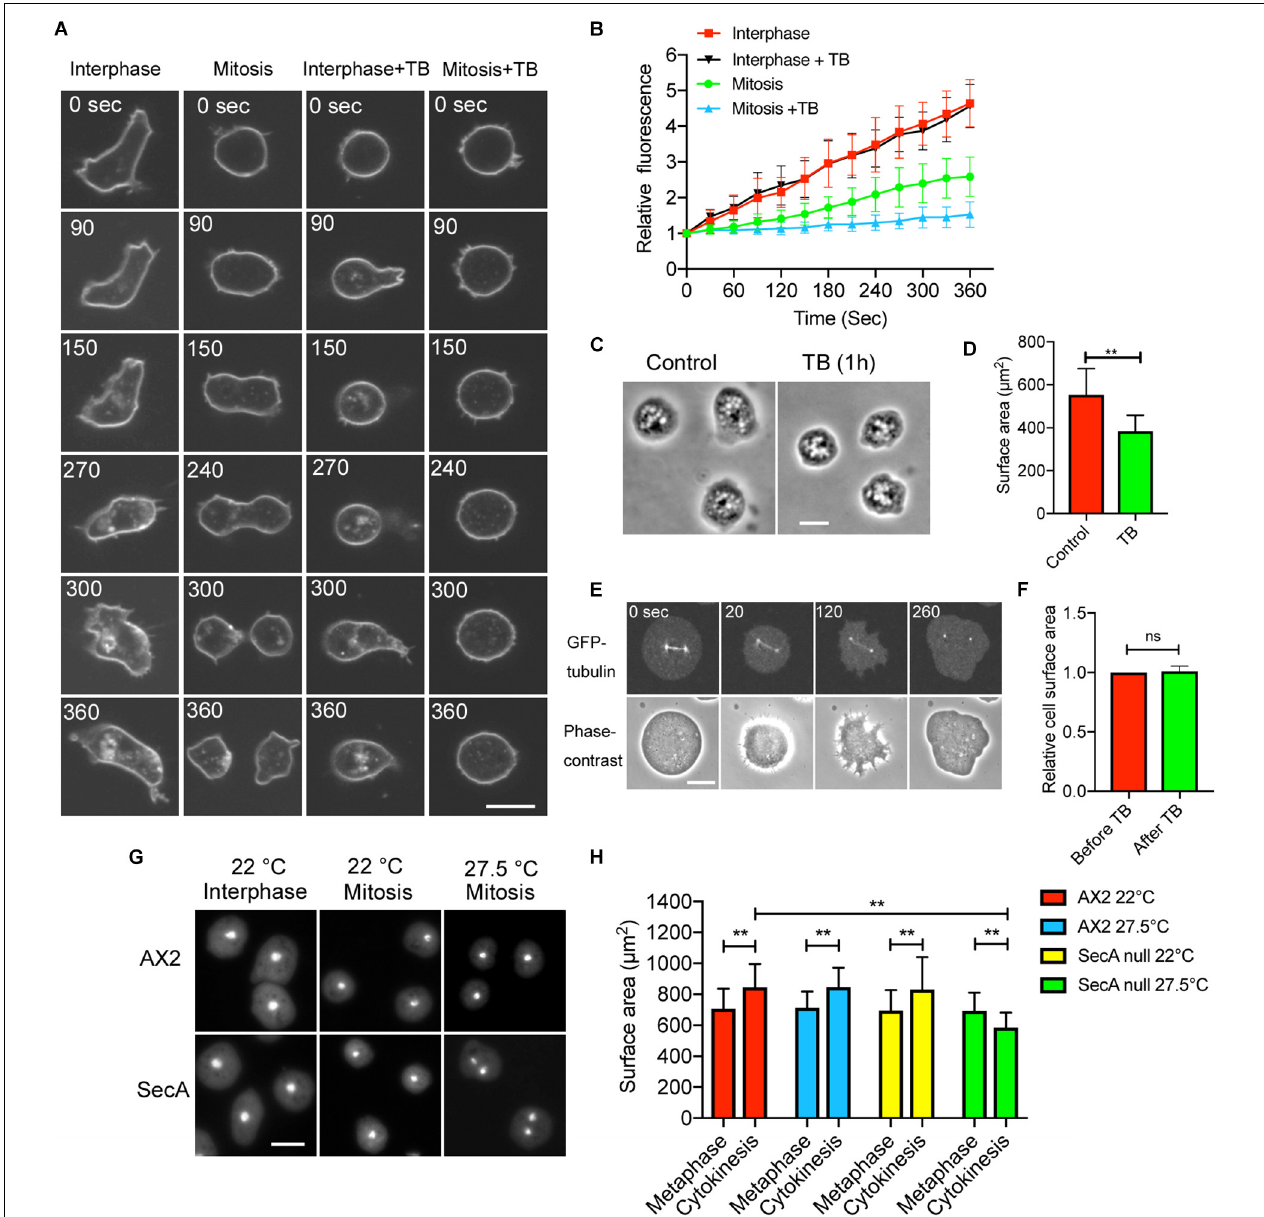
FIGURE 2 | Membrane uptake is suppressed during cell division. (A) Time course of typical fluorescence images of cells at the interphase and during mitosis in the presence of FM1-43 (interphase, mitosis, interphase + TB, and mitosis + TB; TB: thiabendazole). In these experiments, the cells were stained without an agar overlay. Bar: 10 µ m. (B) Time course of the fluorescence intensity of the inside (internalized membrane) of the cells stained with the FM dye in each condition (mean ± SD, n = 20). (C) Typical phase-contrast images of cells incubated before and 1 h after addition of TB. Bar: 10 µ m. (D) Surface area of the cells in each condition. Data are presented as the mean ± SD and analyzed by Student’s t -test. ** P ≤ 0.001, n ≥ 130. (E) Time course of fluorescence and phase-contrast images of the dividing cells expressing GFP-tubulin after the addition of TB. Because TB was added to the surface of the agar block, the cells were transiently raised (therefore, the cells shrunk slightly), but thereafter, the cells became flat. Note that the spindle disappeared 260 s after the addition of TB, and the cells were not able to undergo cytokinesis becoming binucleate. Bar: 10 µ m. (F) Comparison of the surface area before and after addition of TB. Data are presented as the mean ± SD and analyzed by Student’s t -test. ns, not significant, P > 0.05, n = 44. (G) Typical fluorescence images of wild type (AX2) and secA null cells stained with 4 (cid:48) ,6-diamidino-2-phenylindole (DAPI). Interphase cells cultured at 22 ◦ C, divided cells immediately after cytokinesis when cultured at 22 ◦ C, and divided cells immediately after cytokinesis when cultured at 27.5 ◦ C. secA null cells failed cytokinesis, resulting in binucleate cells at 27.5 ◦ C. Bar: 10 µ m. (H) Comparison of the total cell surface area in wild type and secA null cells at the metaphase, cytokinesis (22 ◦ C), or failed cytokinesis (27.5 ◦ C). Here, we used TB for cells to be arrested at mitotic stage (Metaphase) and removed TB by media exchange to restart the cell division (Cytokinesis) at each temperature. Because the microtubule structures fully reappeared within 5 min, exocytosis was not affected with TB. Data are presented as the mean ± SD and analyzed by one-way ANOVA with Tukey’s multiple comparisons test. ** P ≤ 0.001, n >